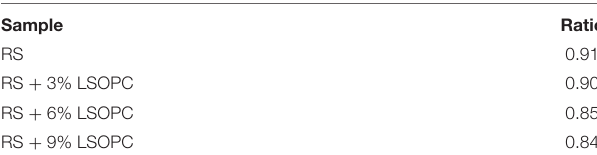
TABLE 3 | Ratios of absorbance values from the infrared spectra at 1,047 and 1,022 cm − 1 . Sample